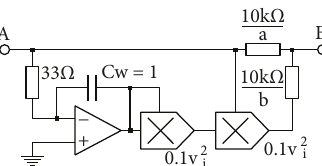
Figure 2: The alternative circuit of memductor based with speci fi c